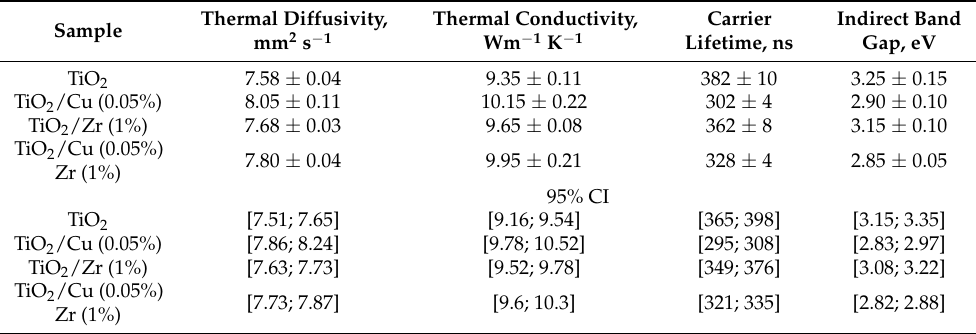
Table 2. Values of the thermal, optical and transport properties for the unmodified and Cu- and/or Zr-modified TiO 2 from the best fits between the experimental and theoretical data.